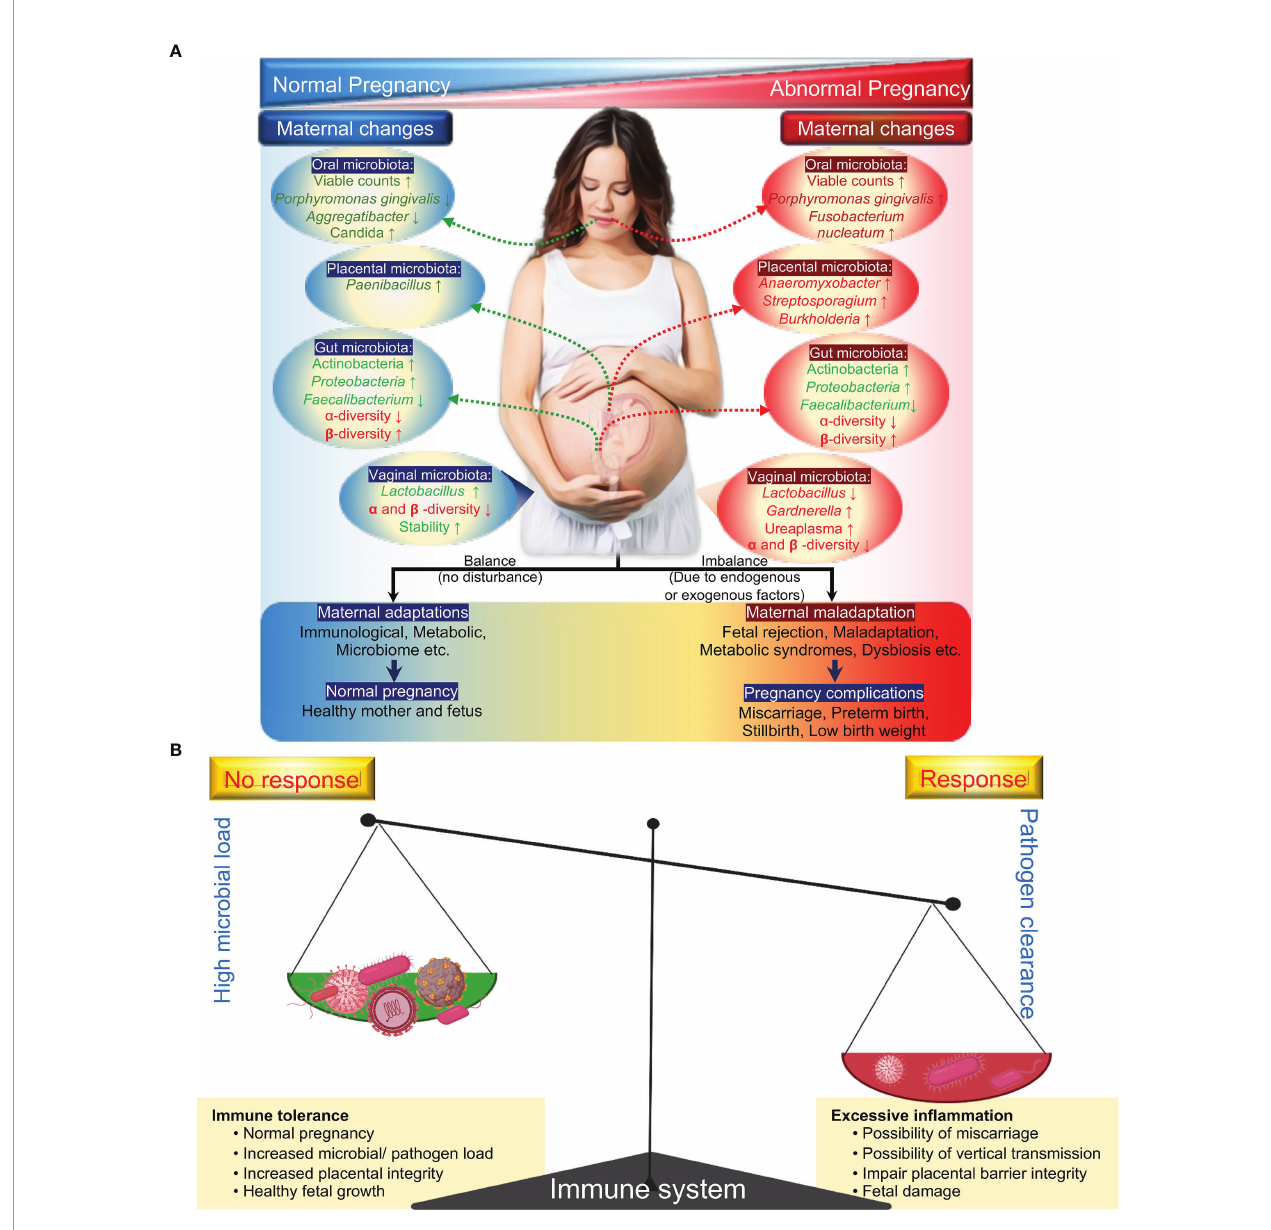
FIGURE 1 | General microbial dynamics during health pregnancy and complicated pregnancy. Known changes in the microbial composition: changes in a speci fi c taxonomy (green) and changes in community diversity (red) (A) . Immune response during pregnancy: double-edged sword (B) . During pregnancy, the maternal immune system has to balance between sustaining the growth of the fetus and protecting both mother and fetus from